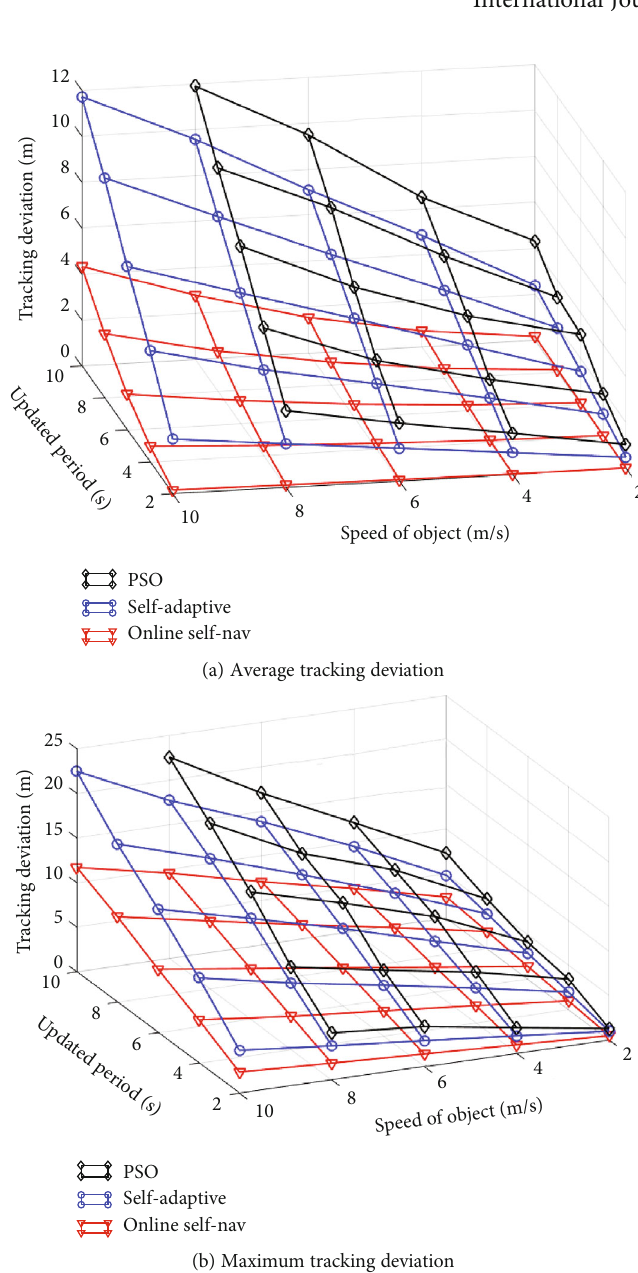
Figure 10: Tracking deviation error — the distance between the orthogonal projection of the UAV onto the ground and the object center during the tracking phase. The PSO team did not fi nd out the object at a speed of